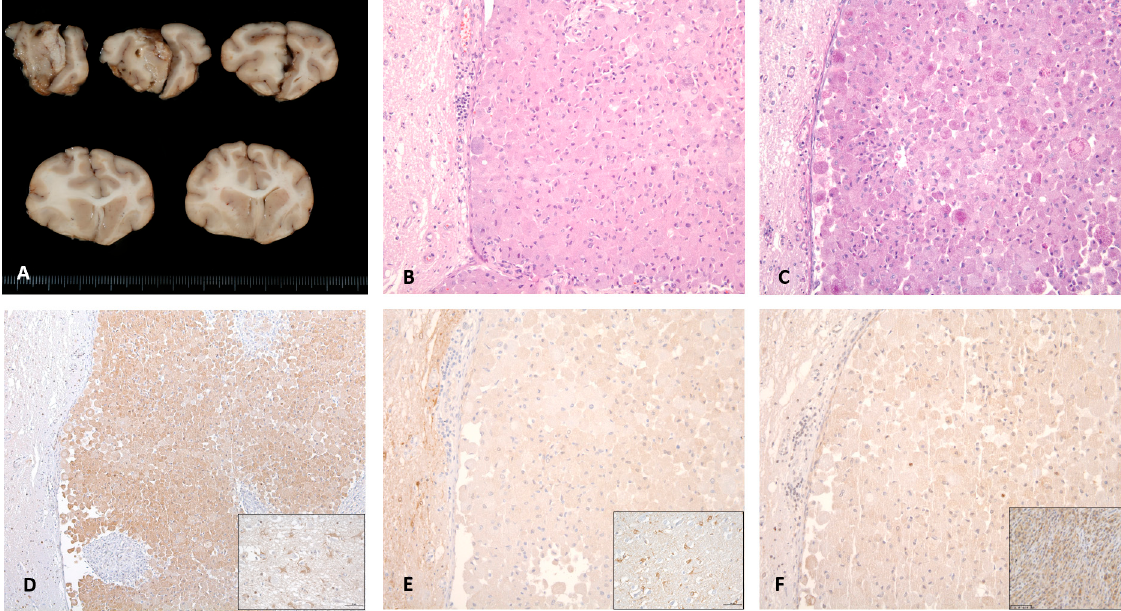
Figure 4. Macroscopic, histological and immunohistochemical features of Case 2. Caudal view of cerebral cross-sections. ( A ) Whitish multilobulated mass can be seen affecting the olfactory bulb with a diffuse enlargement of the left cerebral hemisphere. ( B ) Haematoxylin and eosin staining revealed neoplastic cells growing in sheets, with ( C ) a wide cytoplasm containing PAS-positive granules and ( D ) a strong expression of cytoplasmic ubiquitin protein. No immunoreactivity was detected against the ( E ) S-100 and ( F ) SOX-10 proteins. Positive controls of ubiquitin, S-100 and SOX-10 are shown in each